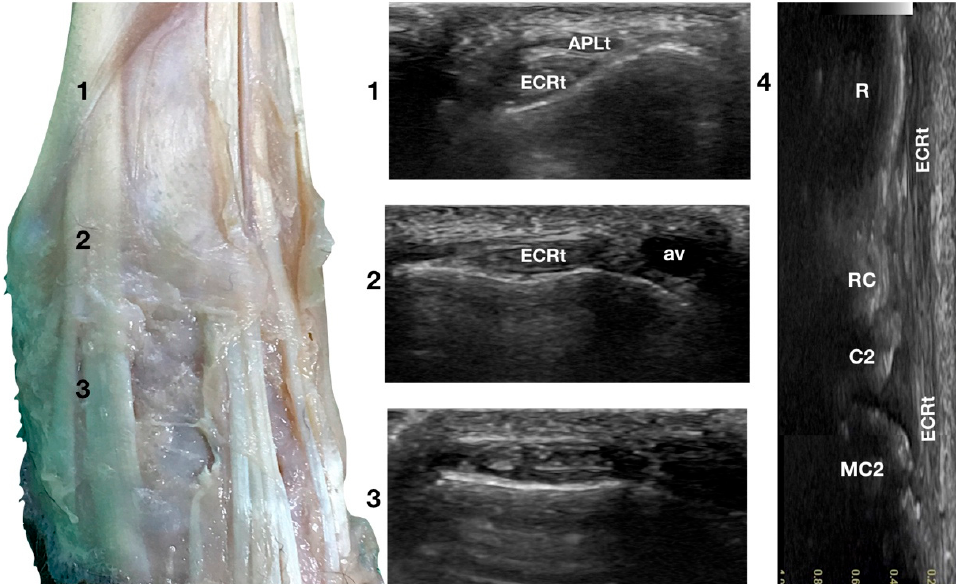
Figure 2. Dorsal carpal face centred on the Extensor Carpi Radialis tendon. At point 1, the APL superficial and thin emerging tendon covers the thick tendon of the ECR. At the ulnar notch of the radius (2), the ECR tendon is easily recognised due to the thick hyperechoic layer that defines its contour (peritendineum). Medial to the tendon, the accessory cephalic vein (av) is visible. At the intercarpal joint (3), the tendon subdivides into the smaller medial part and the more significant lateral part, as is easily seen in the image. However, they are still enclosed in the same tendon sheath that completely divides into two tendons distally. Image 4 is the visualisation of the longitudinal image of the medial portion of the ECRt. The bony surface beneath is recognisable. R, radius; RC, radiocarpal bone; C2, carpal bone two; MC2, second metacarpal bone.